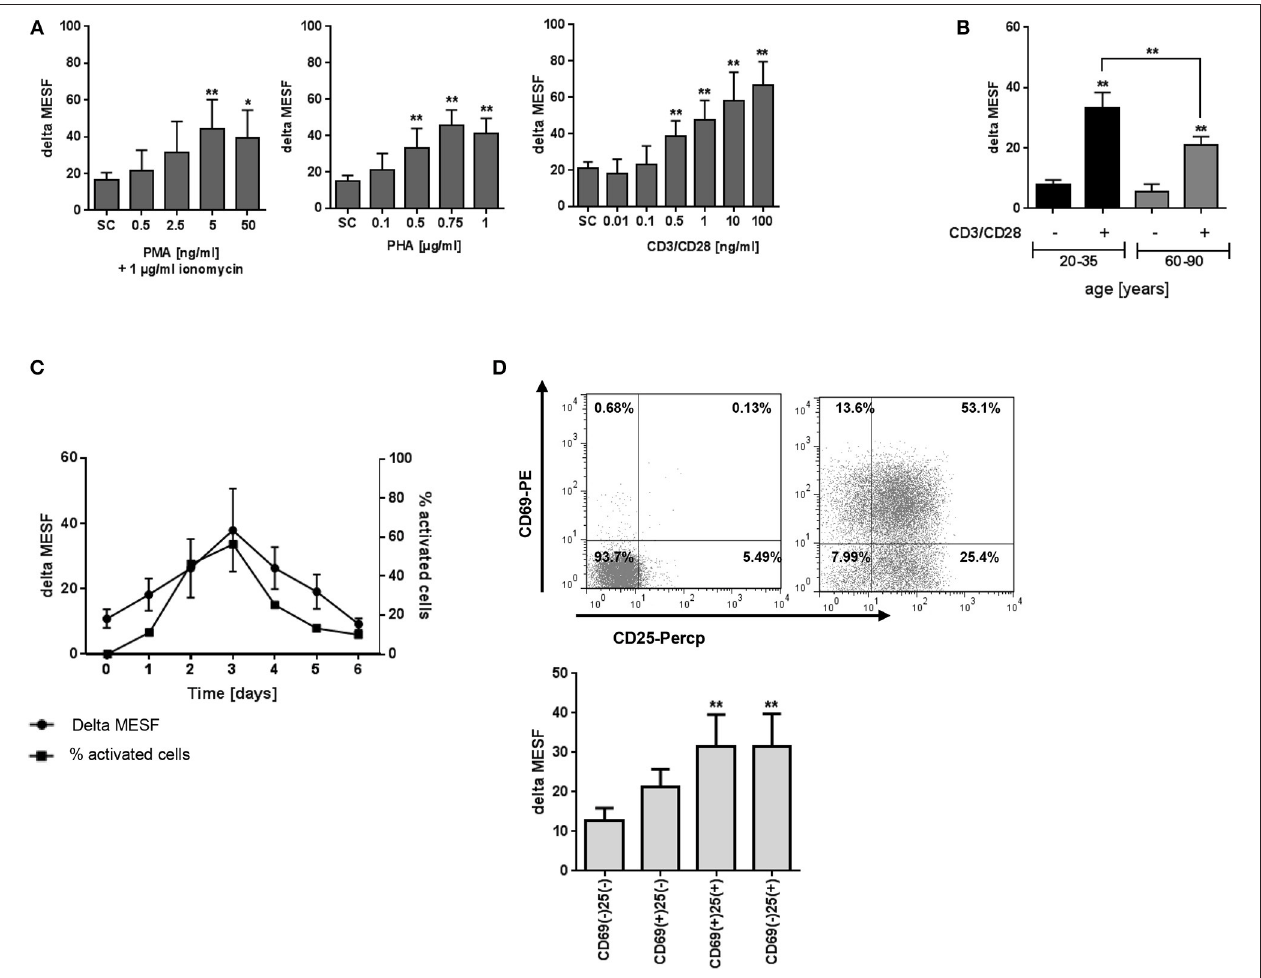
FIGURE 2 | Effect of activation on T2R38 expression in PBMC. (A) PBMC were stimulated with different concentrations of PMA/ionomycin (1 µ g/ml), PHA or anti-CD3/CD28 mAbs for 72h ( n ≥ 5) (B) Isolated PBMC from young and elderly individuals were stimulated with 1ng/ml CD3/CD28 for 72h ( n ≥ 5) (C) PBMC were stimulated with 1ng/ml CD3/CD28 for the indicated time points, activated cells were determined by the percentage of blast cells ( n ≥ 3) (D) PBMC were stimulated with 1ng/ml CD3/CD28 and T2R38 expression on CD69 + /CD25 + CD3 + T lymphocytes determined at the indicated time points ( n = 5). A representative staining of surface markers CD69 + /CD25 + at day 2 from one subject is shown as scattergram. T2R38 expression (delta MESF) was assessed by Quantum Alexa Fluor 488 MESF beads in comparison to rabbit IgG isotype control; bars are means + SD (A,B) or means ± SD (C,D) . Significance of difference was calculated relatively to the respective control, * p < 0.05; ** p < 0.01. SC, solvent control. The gating strategy is shown in Supplementary Figure S2 .